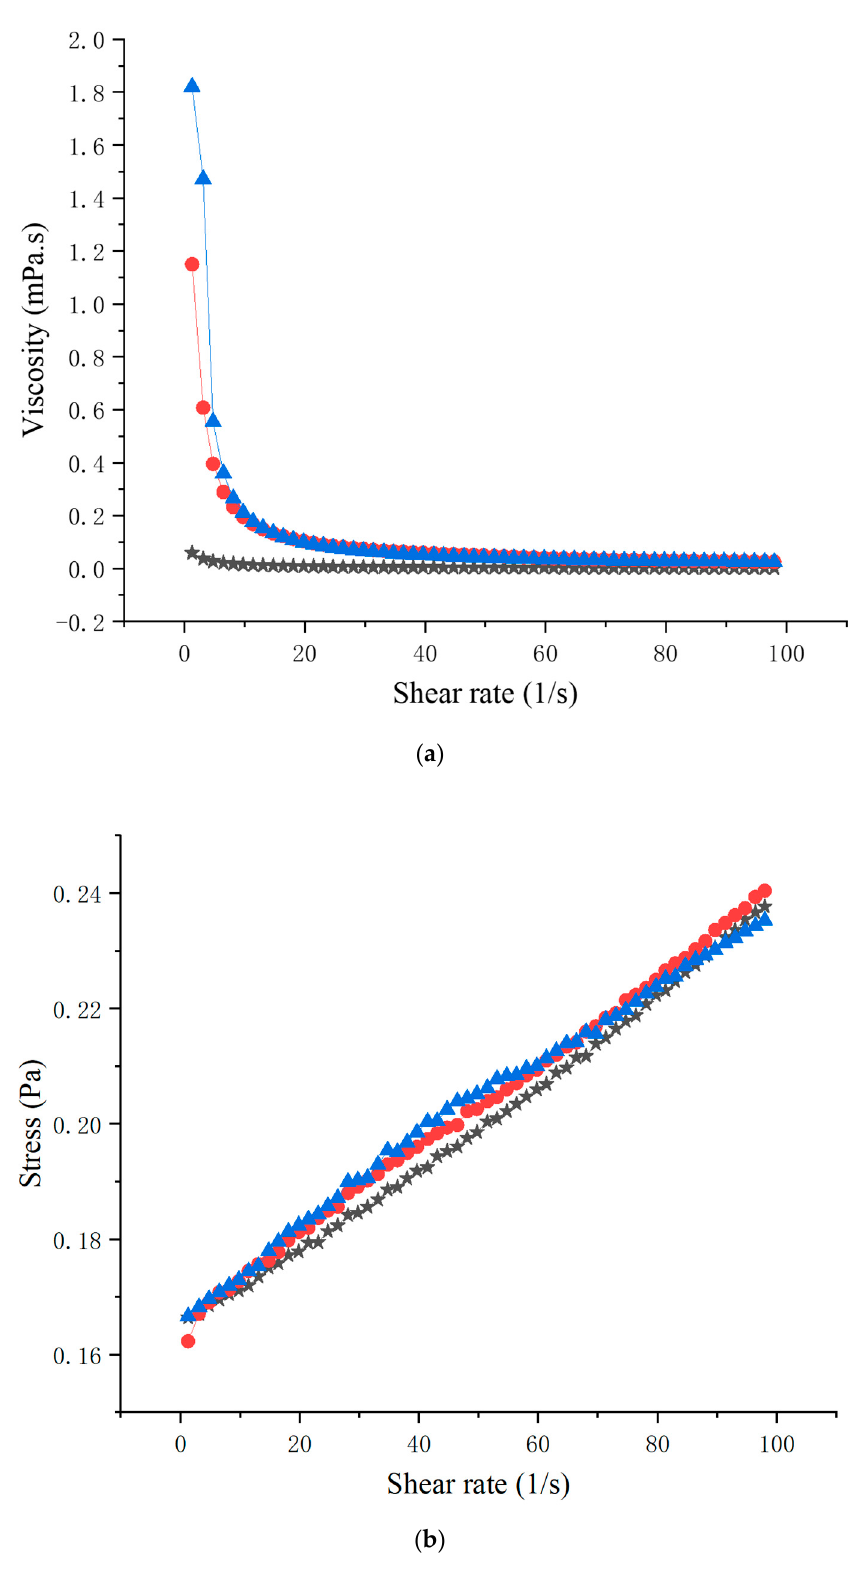
Figure 1. Shear rate viscosity curves of different soups ( a ); Shear stress shear rate curves of different soups ( b ). represent chicken soup, represent ginger chicken soup. represent ginger soup,